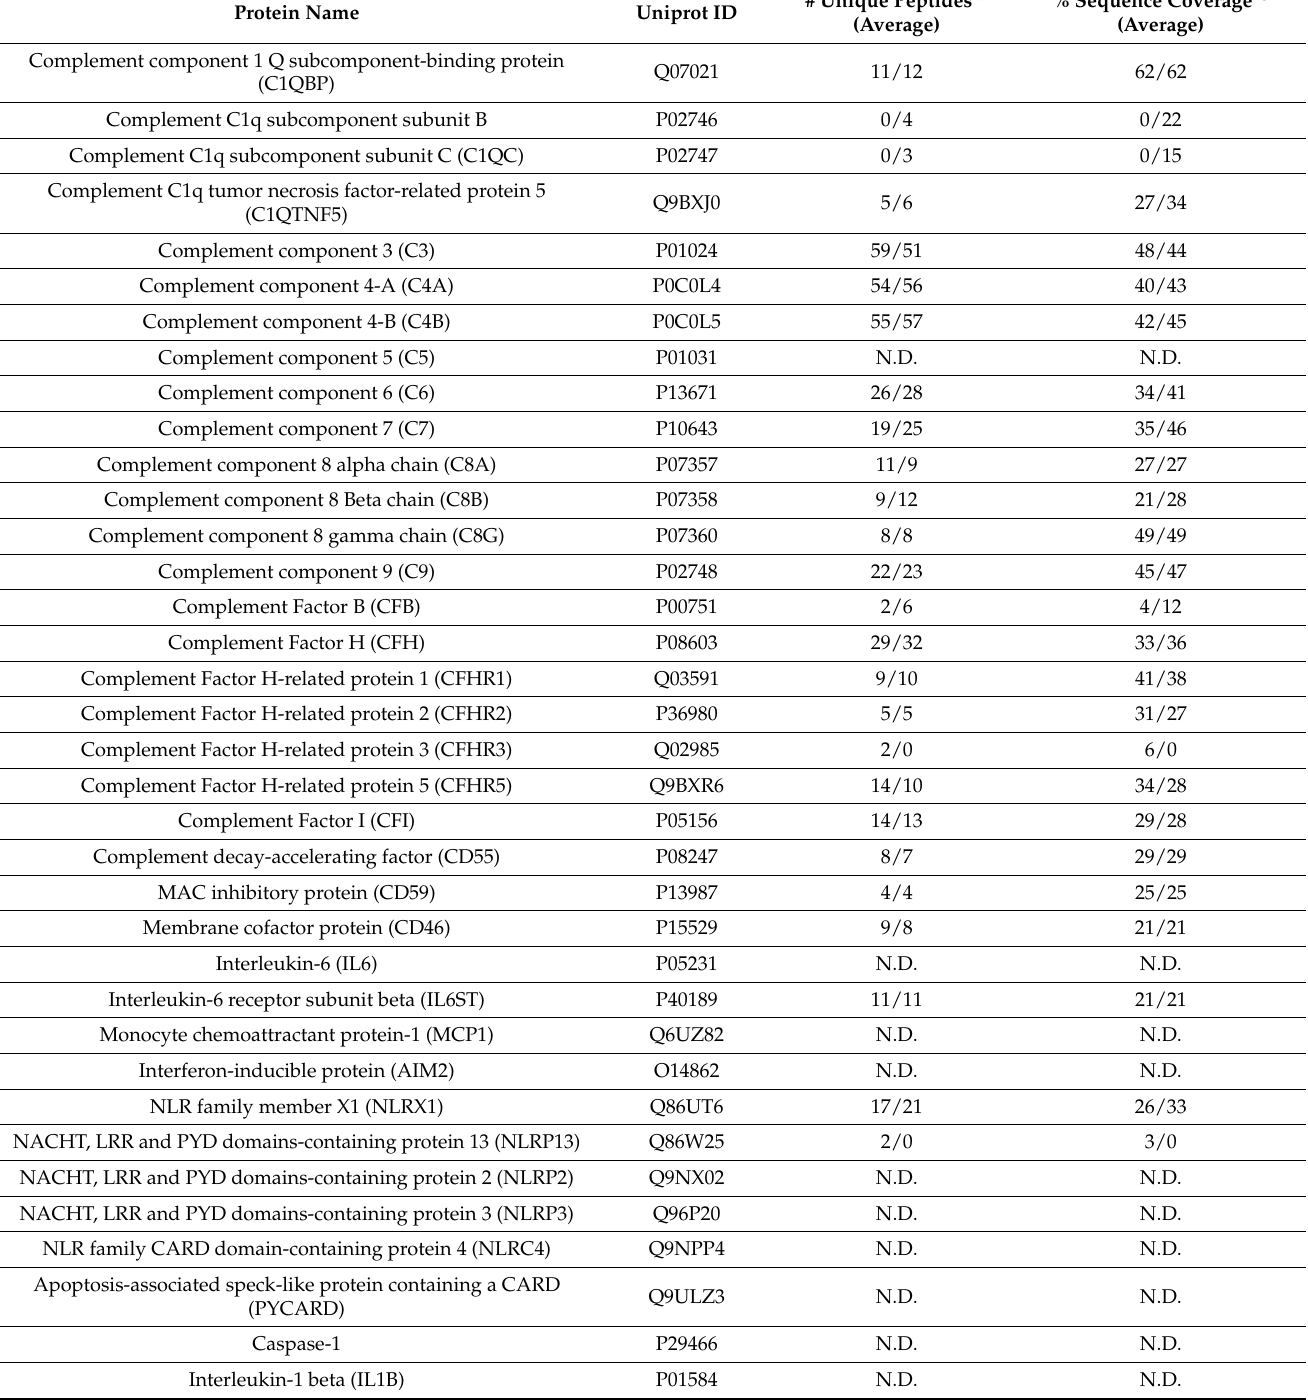
Table 1. Mass spectrometry identification of complement and inflammasome proteins in RPE A